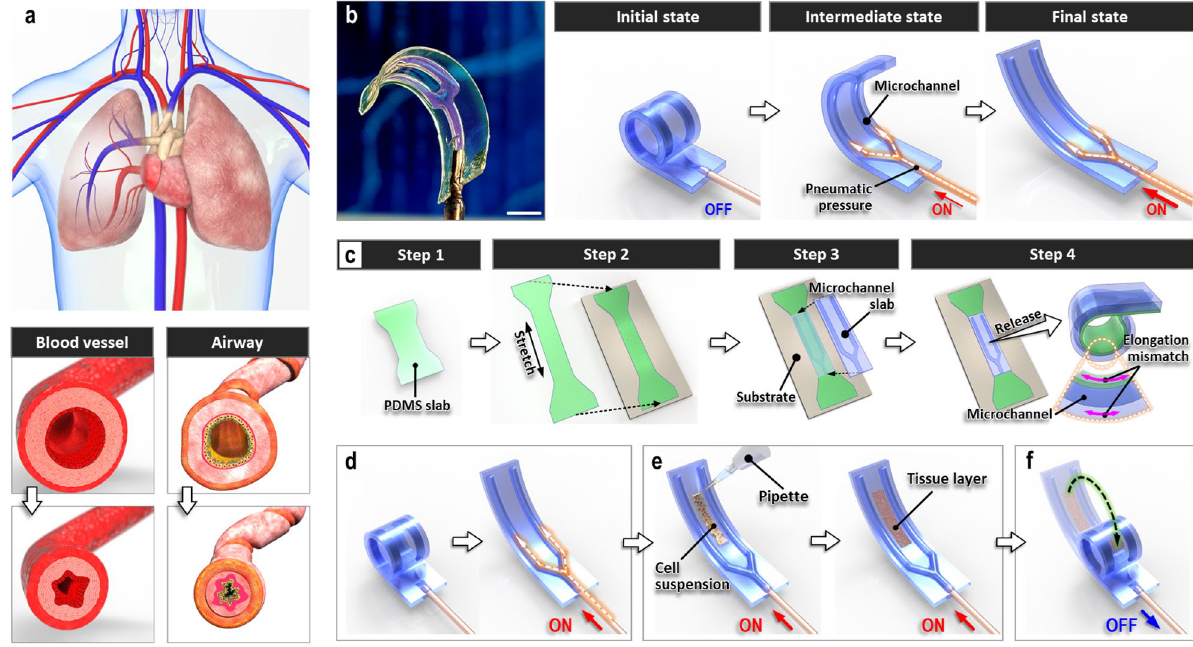
Figure 1. A soft-robotic constrictor for dynamic compressive mechanical loading of living tissue. ( a ) Circumferential tissue compression occurs during the constriction of tubular organs such as blood vessels and airways. ( b ) Normally coiled soft robotic cell culture platform and its pneumatically driven unrolling motion. Scale bar, 5 mm. ( c ) Fabrication of the soft robotic device through irreversible bonding of a thin stretched PDMS strip to a microchannel-containing PDMS slab (Steps 1, 2, and 3) and subsequent release of the bonded assembly (Step 4). ( d,e ) Sequential steps for establishing cell culture on the microengineered device. Red arrows labeled “ON” at the bottom of schematics represent application of pneumatic pressure to the microchannels. ( f ) Compression of cultured tissue layer through removal of air pressure from the microchannels (shown with a blue arrow labeled “OFF”) and the resultant bending of the culture